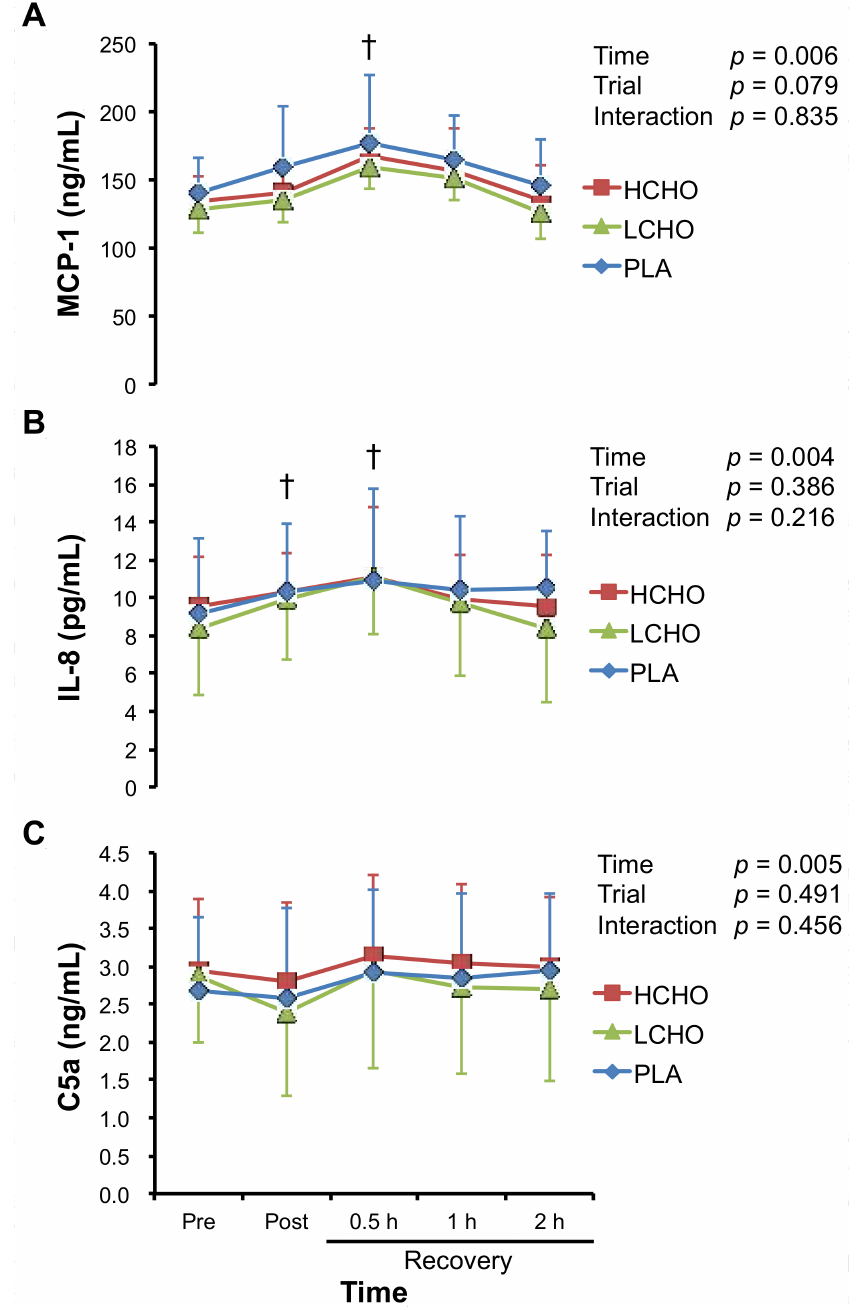
Figure 3. Changes in plasma monocyte chemotactic protein-1 (MCP-1) ( A ), interleukin-8 (IL-8) ( B ), and complement component 5a (C5a) ( C ) concentrations in response to endurance exercise. HCHO, high-carbohydrate trial; LCHO, low-carbohydrate trial; PLA, placebo trial; Pre, pre-exercise; Post, immediately after exercise; 0.5 h, 0.5 h after exercise; 1 h, 1 h after exercise; 2 h, 2 h after exercise. † p < 0.05 vs.